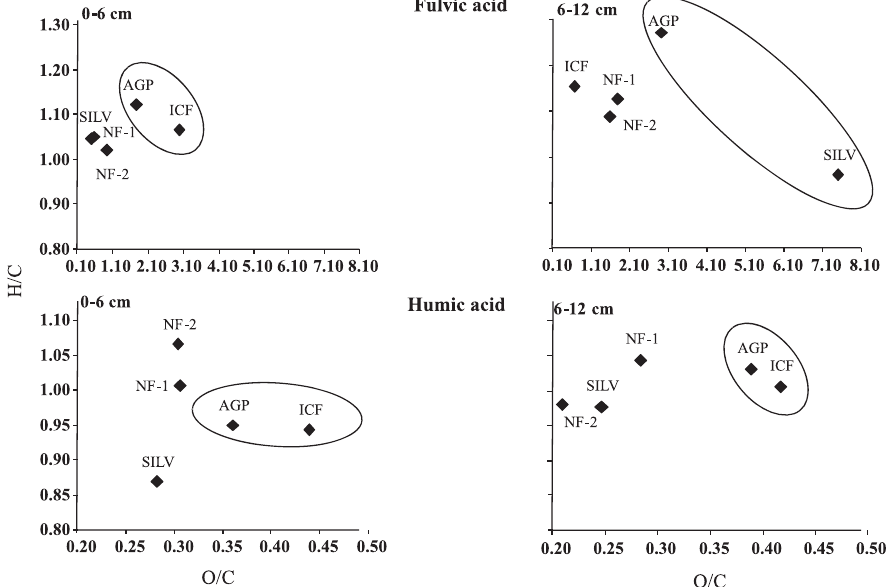
Figure 2. Relationships between H/C and O/C atomic ratios of the fulvic and humic acids extracted from the layers 0–6 and 6–12 cm of a chromic Luvisol under agroforestry, intensive cultivation, and native forest. AGP: agrosilvopasture; SILV: silvopasture; ICF: intensive cultivation under fallow; NF-1: native forest compared to AGP and SILV treatments; NF-2: native forest compared to the